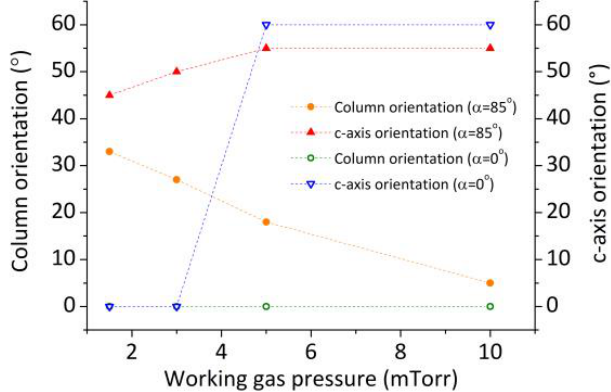
Figure 8. Plot illustrating variation of AlN column and c-axis tilts for both growth configurations at different working gas pressures.